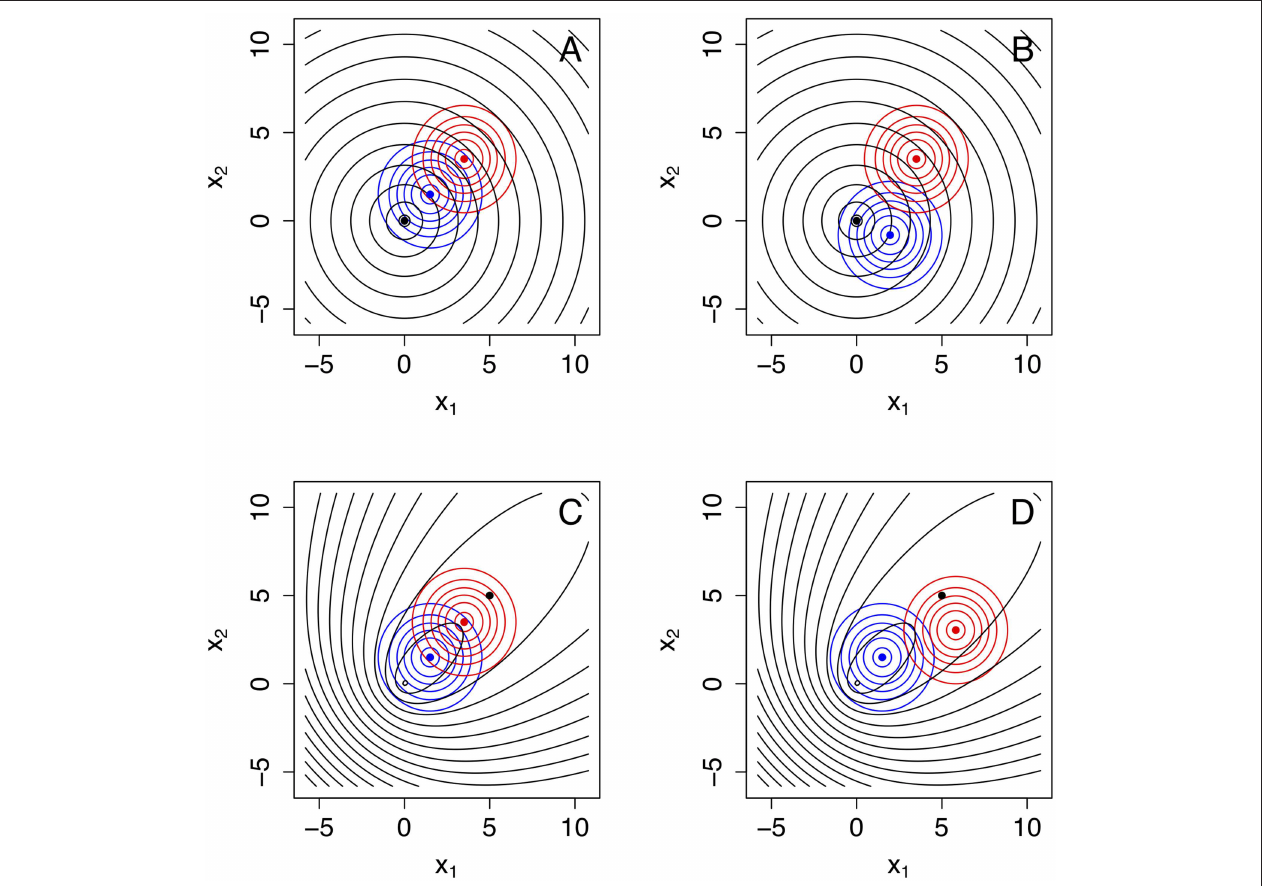
FIGURE 4 | Four model configurations involving a bivariate generating process g ( x 1 , x 2 ) (in black), and two approximating models f 1 ( x 1 , x 2 ) (in blue) and f 2 ( x 1 , x 2 ) (in red). In all cases the approximating models are bivariate normal distributions whereas the generating process is a bivariate Laplace distribution. These model configurations are useful to explore changes in α ′ (Equation 53), β ′ (Equation 59) and M ′ i , W i , i 1,2 (Equations 71, 72) as a function of sample size, as plotted in ′ = Figure 6 . (A) g ( x 1 , x 2 ) is a bivariate Laplace distribution centered at 0 with high variance. All three models have means aligned along the 1 : 1 line and marked with a black, blue, and red filled circle, respectively. Model f 1 ( x 1 , x 2 ) is closest to the generating process. (B) Model f 1 ( x 1 , x 2 ) is still the model closest to the generating process, at exactly the same distance as in (A) but misaligned from the 1 : 1 line. (C) Here all three models are again aligned, but the generating process g ( x 1 , x 2 ) is an asymmetric bivariate Laplace that has a large mode at 0,0 and smaller mode around the mean, marked with a black dot. In this case, the generating model is closer to model f 2 ( x 1 , x 2 ) (in red). (D) Same as in (C) , except model f 2 ( x 1 , x 2 ) (in blue) is now misaligned, but still the closest model to the generating